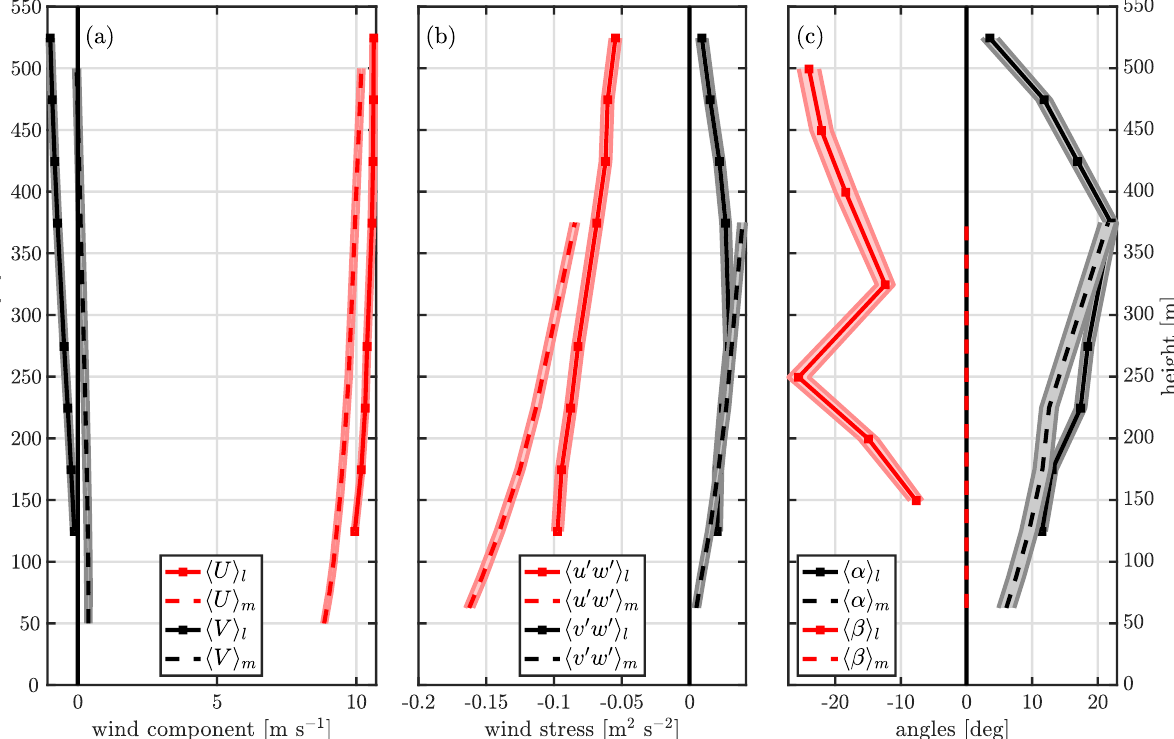
Figure 3. Mean vertical profiles of ( a ) horizontal wind components, ( b ) momentum fluxes and ( c ) wind turning angles at FINO3. The full lines are lidar observations ( l ) and dashed lines represent the NEWA-WRF output ( m ). All profiles are within 270° ± 45° and are computed from 3343 30-min samples, where the shaded areas represent the standard errors of the